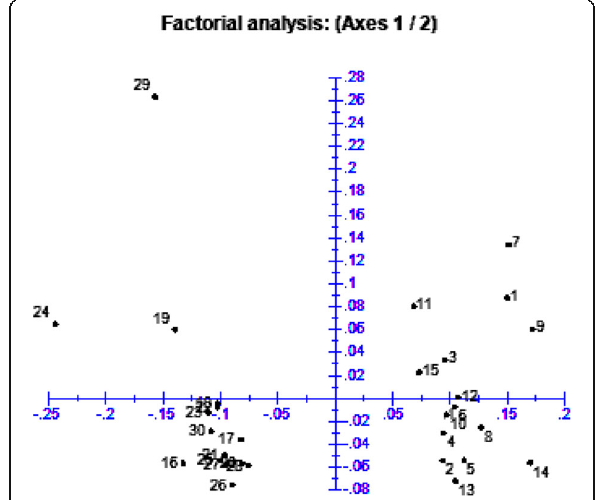
Fig. 3 Principal coordinate analysis of 30 sweet sorghum genotypes using 24 TRAP marker combinations using the dissimilarity distance